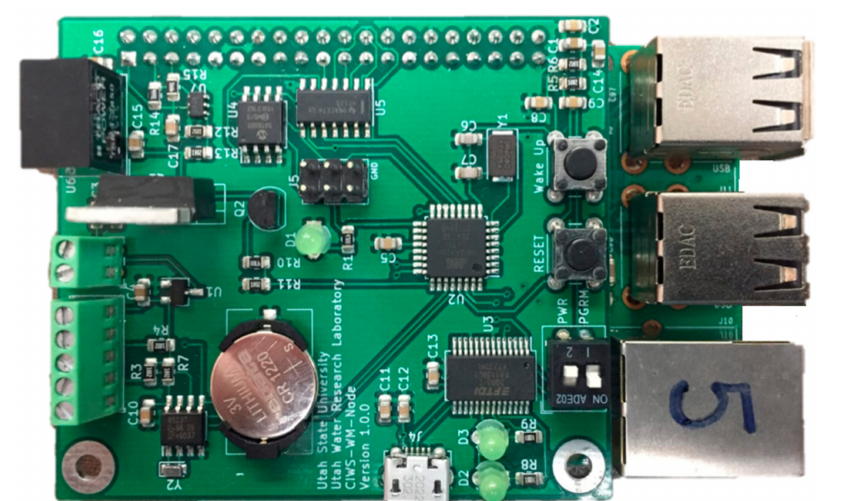
Figure 3. Printed circuit board implementation of the CIWS computational node. This board is designed to mount directly to the pin header of the Raspberry Pi computer (shown underneath the PCB) and includes all of the hardware components on a single